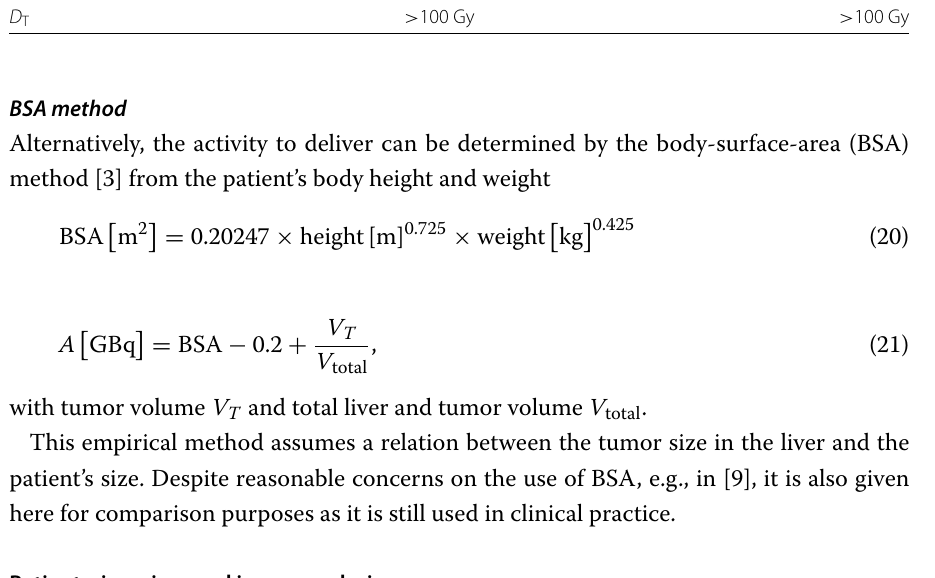
Table 1 Dose thresholds for lung, normal liver, and tumor according to [8] represented by T 1 and dose thresholds T 2 published and discussed in [9] T 1 T 2 D L 25 Gy 25 Gy D NL 70 Gy 40 Gy D T > 100 Gy > 100 Gy